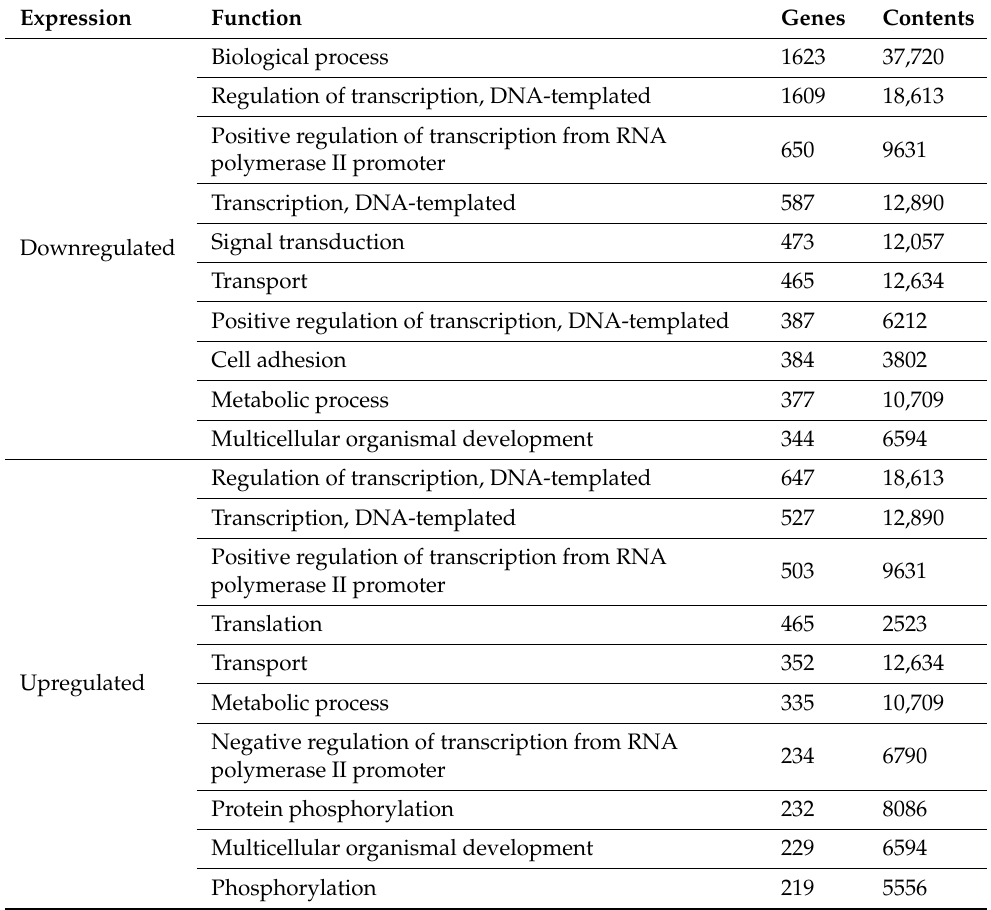
Table 1. The top 10 functions that were significantly down- or upregulated following theanine